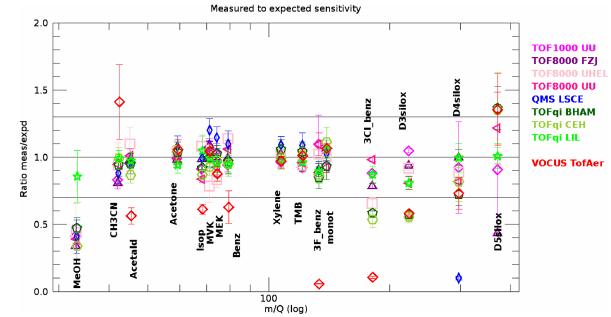
Figure 4. Mean measured sensitivities for all compounds in the gas standards and all PTR-MS instruments. The error bars repre- sent the standard deviation of all calibrations with dry N 2 or air. The measured sensitivities cover more than 4 orders of magnitude. The compounds (protonated mass in parenthesis) from left to right are methanol (33Th), acetonitrile (42Th), acetaldehyde (45Th), acetone (59Th), isoprene (69Th)/methylbutenol (87Th, main frag- ment on 69Th), methyl vinyl ketone (71Th), methyl ethyl ke- tone (73Th), benzene (79Th), xylene (107Th), trimethylbenzene (121Th), trifluorobenzene (133Th), 3-carene/ α -pinene (137Th), trichlorobenzene (181Th), D3 siloxane (223Th), D4 siloxane (297Th), and D5 siloxane (371Th).